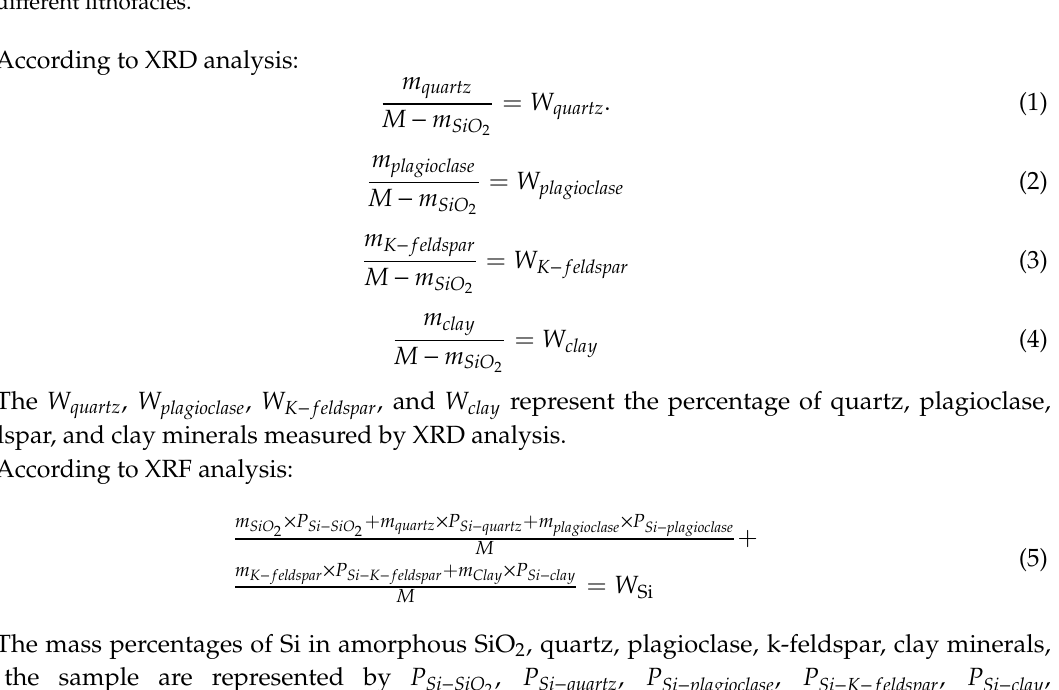
Figure 2. Mineral composition of different lithofacies samples in the Lucaogou Formation. ( A ) The mineral content of the different lithofacies; ( B ) clay mineral composition in the different lithofacies.